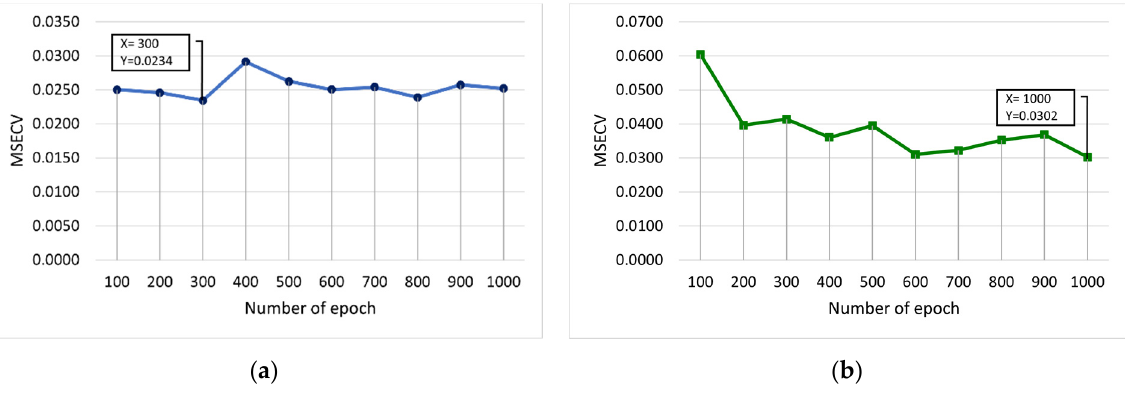
Figure 8. MSECV with varying numbers of epochs for ( a ) FFNN-lm and ( b )